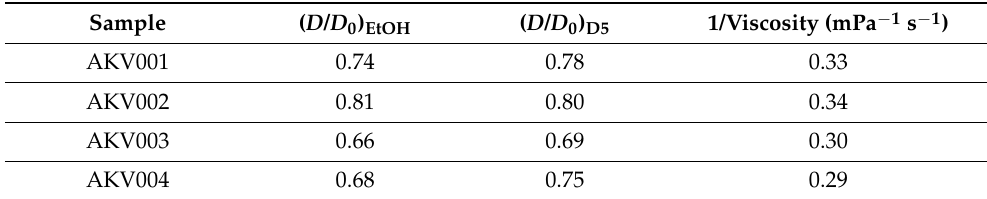
Table 5. Diffusion coefficients of the solvent components normalized to the diffusion coefficients in the pure solvent mixture in the absence of lipids, i.e., in sample